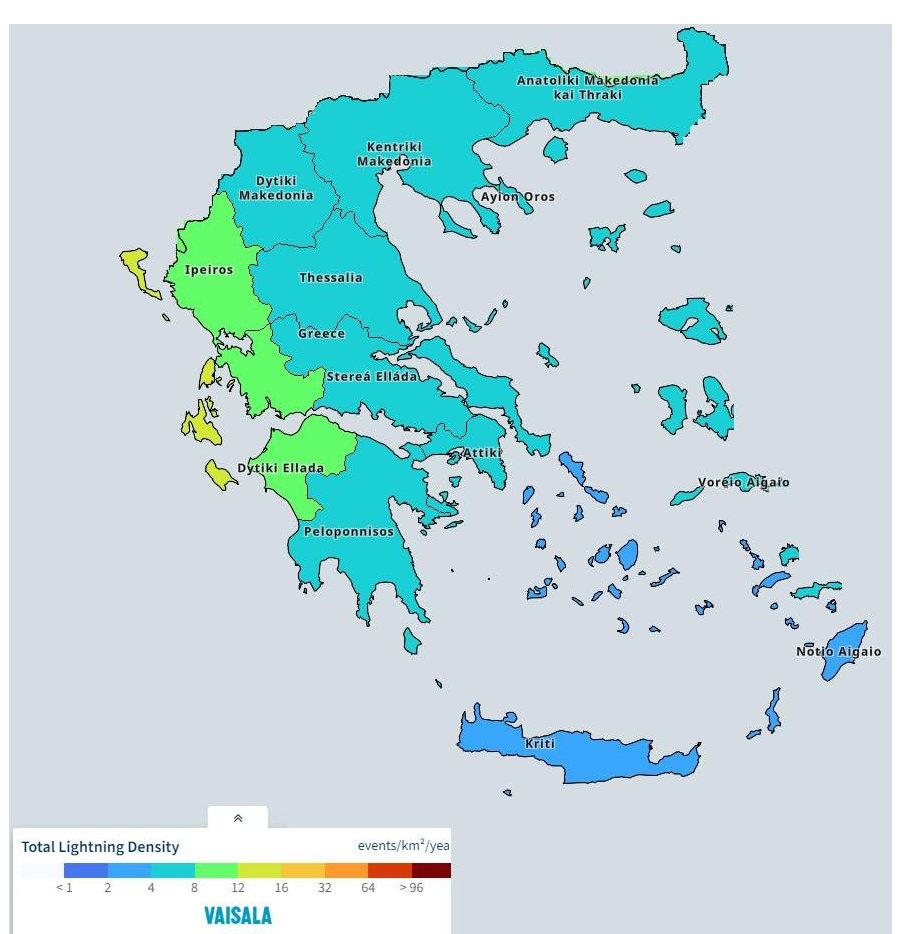
Figure 4. Lightning density map of Greece [21].